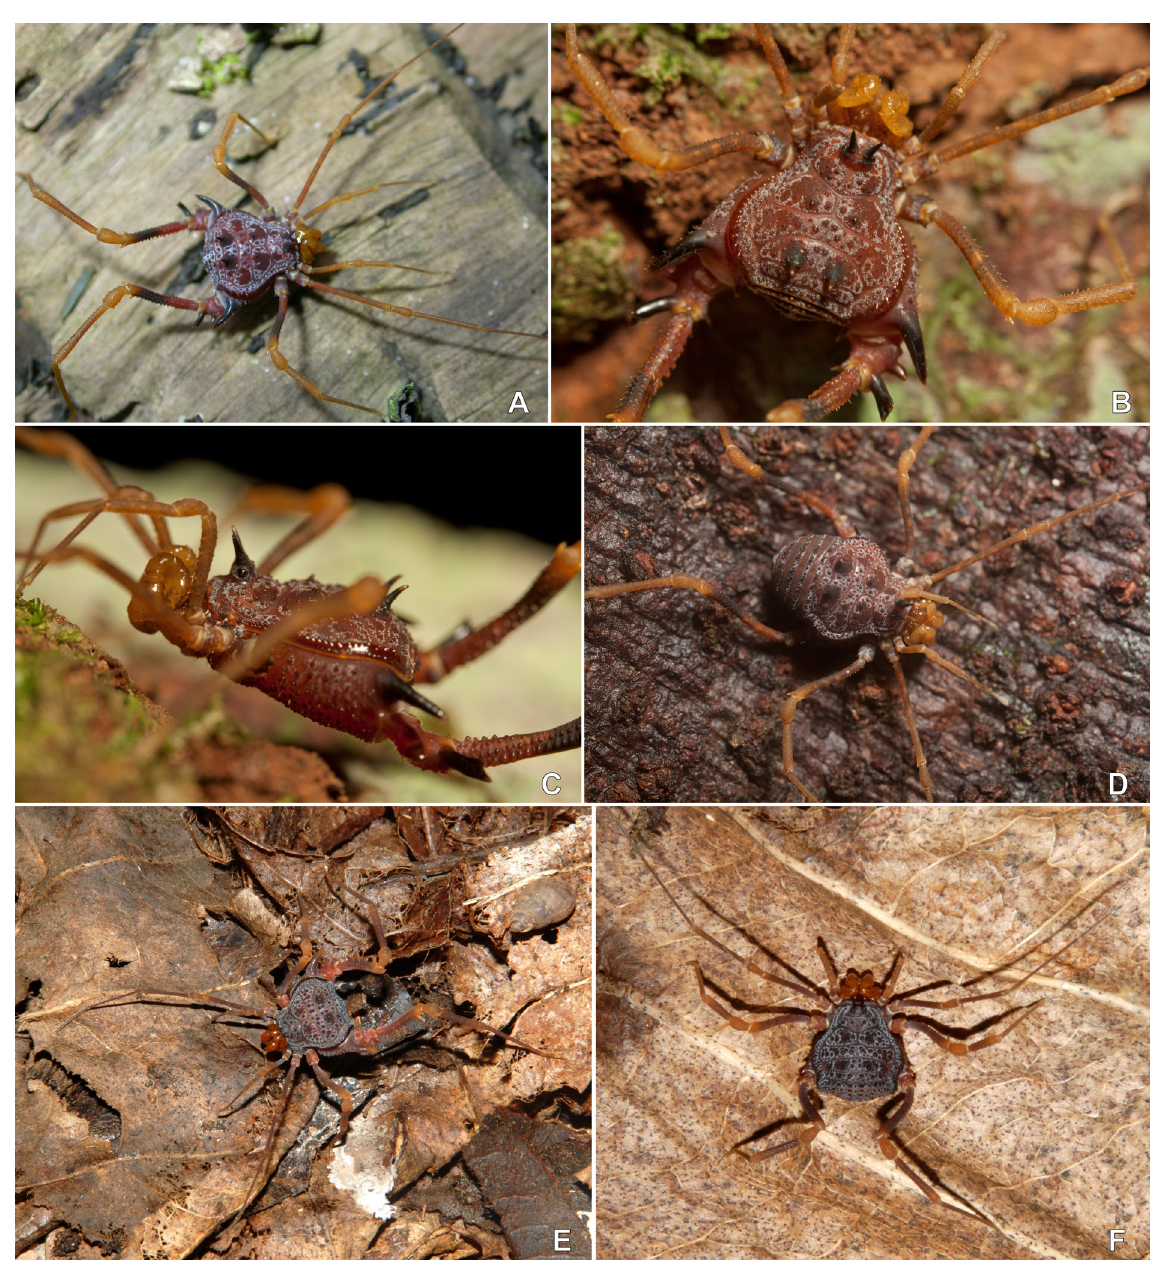
Fig. 1. Amazochroma gen. nov., specimens in vivo. A–D . Amazochroma carvalhoi (Mello-Leitão, 1941) gen. et comb. nov.: A . ♂, Brazil, Amazonas. B–C . ♂, French Guiana, Maripasoula. D . ♀, French Guiana, Maripasoula. E–F . Amazochroma pedroi gen. et sp. nov. E . ♂, Brazil, Rondônia, Monte Negro. F . ♀, Brazil, Rondônia, Porto Velho. Images courtesy of Glauco Machado (A), Sébastien Cally (B–D) and Pedro Martins